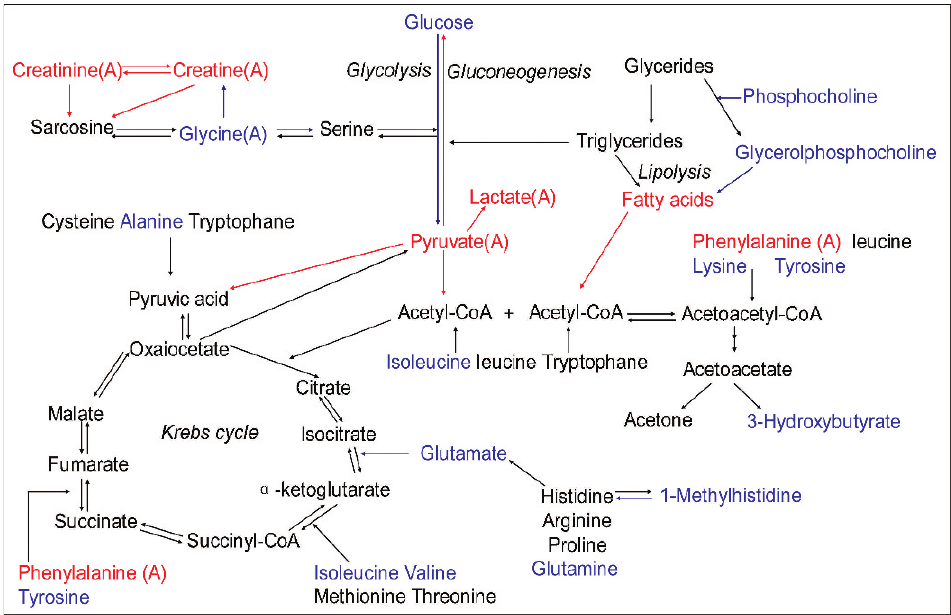
Figure 5 - Summary of the metabolic pathways in which the metabolites described in this article are involved. Red indicates enhanced metabolite levels, blue indicates reduced metabolite levels, and black indicates metabolites not found or not identified. (A) represents the changes only found in the